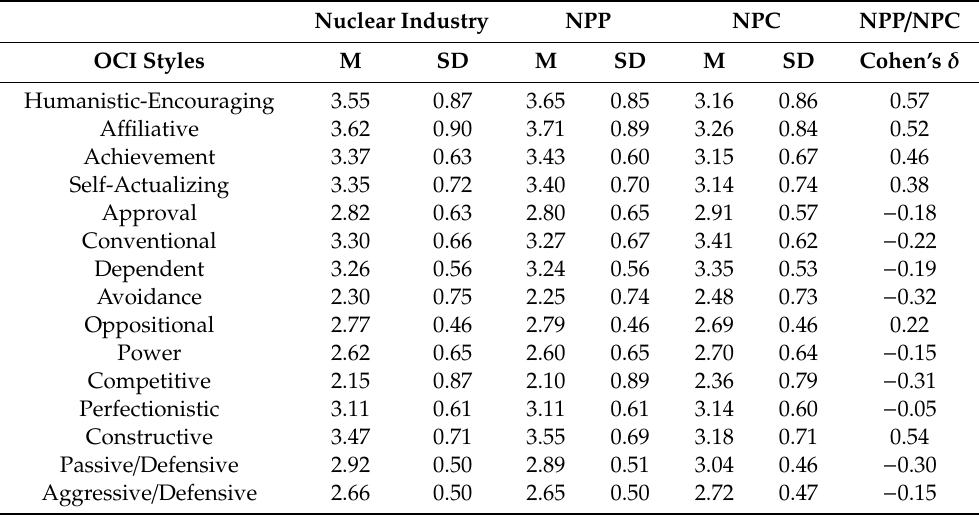
Figure 3. OCI Styles averages.